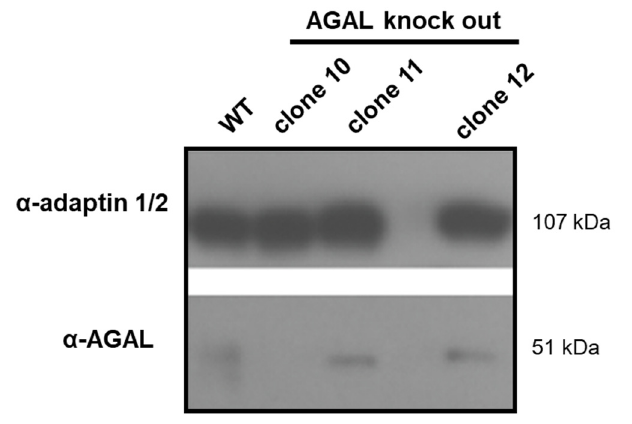
Figure A1. Western blot analysis of AGAL expression in wild-type podocytes (AB8) and CRISPR/Cas9-mediated AGAL-deficient clones. AGAL: α -galactosidase A, WT: wild-type.